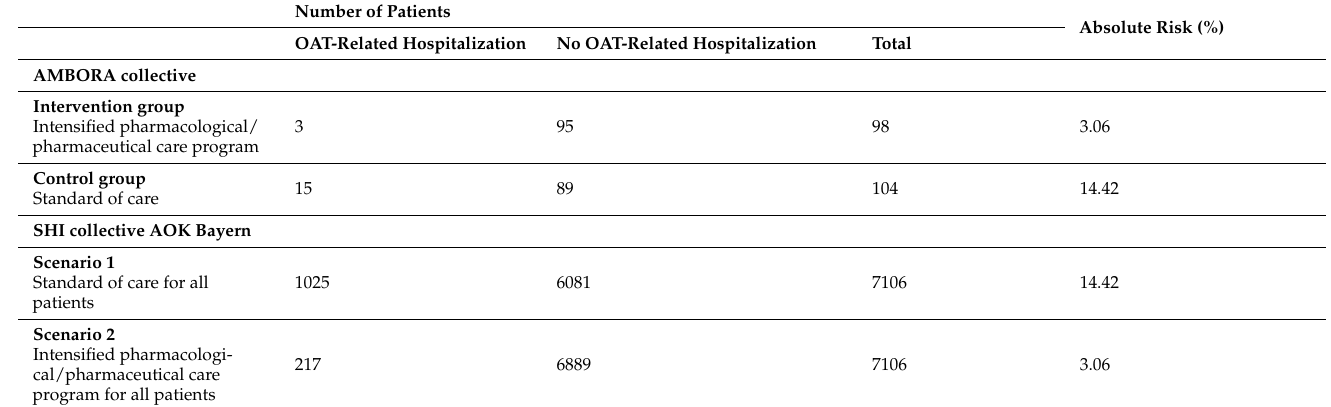
Table 5. Absolute risk for OAT-related hospitalizations derived from AMBORA and scenario analysis of patients in the SHI collective of AOK Bayern treated with new oral anticancer